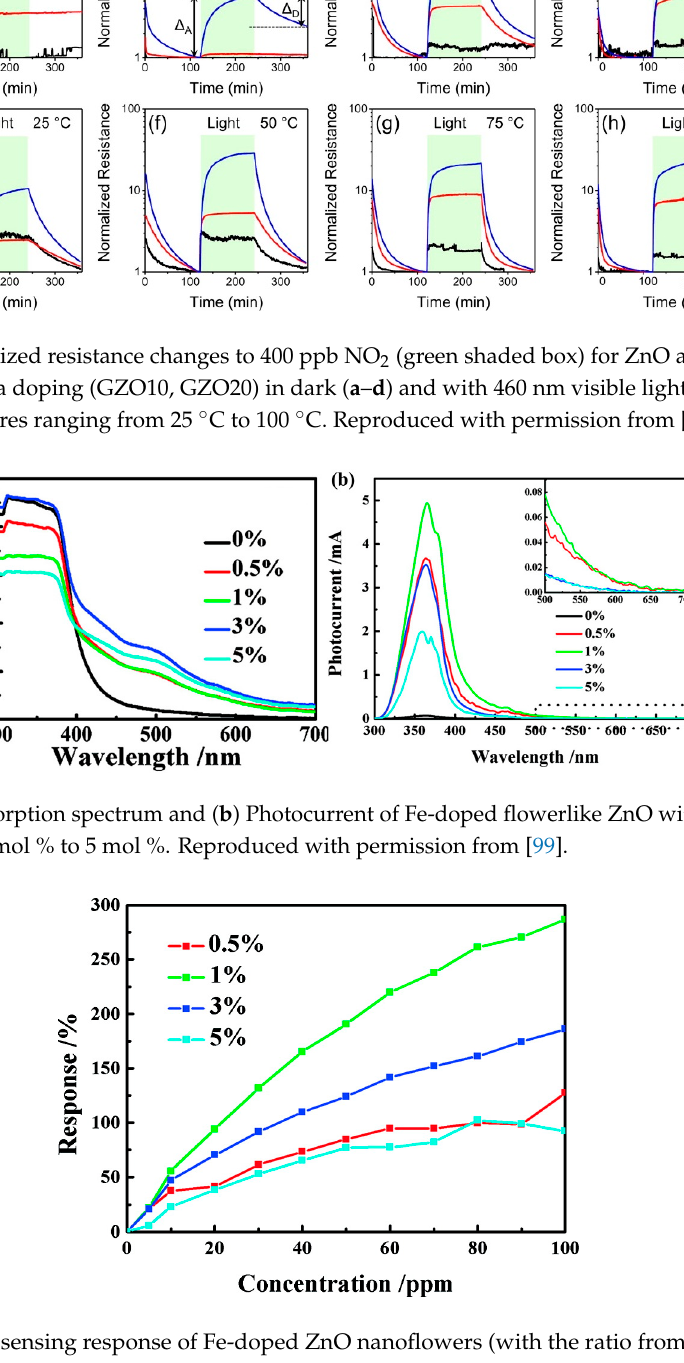
Figure 70. Ethanol sensing response of C doped ZnO microspheres with different calcination temperatures. Reproduced with permission from [101]. Summary This part summarizes the reported results of light-activated gas sensors with the incorporation of dopant, which decreased the resistance baseline, improved sensing response and enabled visible light activation. Detailed summary of these reported work is illuminated in Table 5. Choice of dopant material, concentration and sensors calcination temperature significantly influenced the sensing outcome. It was possible to find an optimal doping amount and annealing temperature for achieving best performance through obtaining the correct crystal property and increasing the density of active